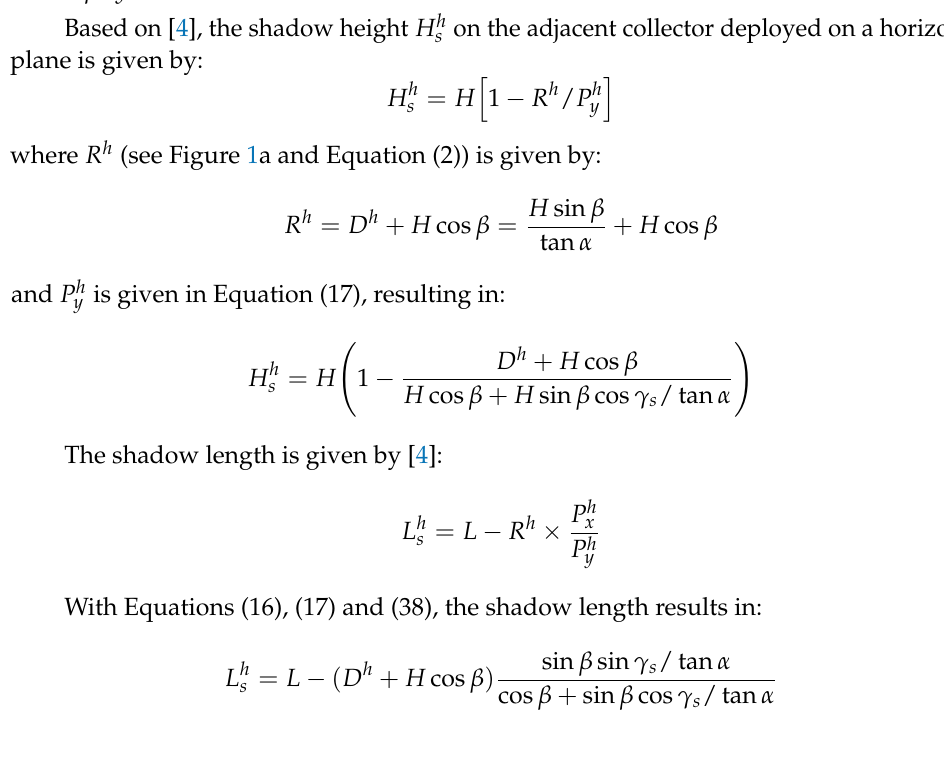
Figure 7. Shadow on a collector deployed on a north-facing sloped plane